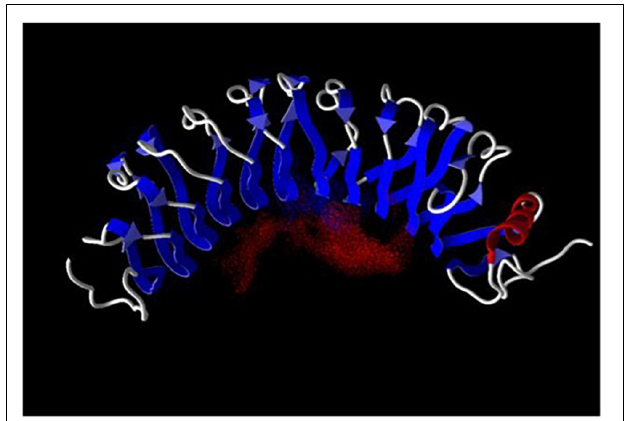
FIGURE 1 | Leucine-rich a 2 -glycoprotein-1 was modeled employing the computer program Molegro (University of Illinois, Urbana-Champaign). Red dots indicate the negative electric field within the ligand binding pocket. Ligand binding-site prediction is based on structural data for a number of other LRR proteins as there are no structural data available for LRG1. The LRRs are shown in blue and α -helix in red.